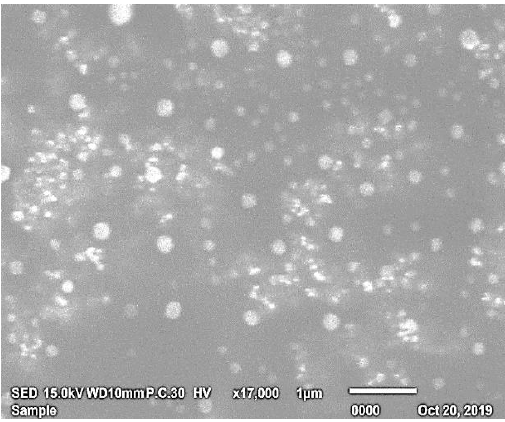
Figure 6. Scanning electron micrograph of the optimized SV-loaded nanospanlastic formula (F8). Abbreviations: SV, Sodium valproate.